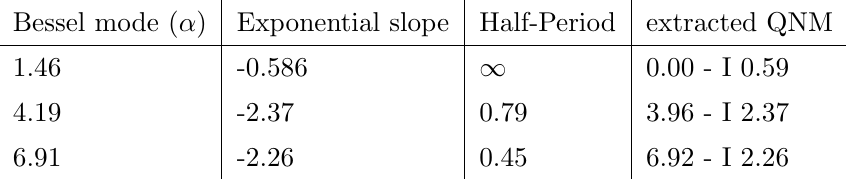
Figure 5 . Late time relaxation analysis after the fast quench. Left panel: time evolution of the Bessel spectrum. The modes with (cid:11) > 2 decay faster and oscillate, while the modes with (cid:11) < 2 decay slower in pure exponential fashion. This is in qualitative agreement with the spectrum of QNMs, (cid:12)gure 4. Right panel: decay of the selected Bessel modes, shown by grid lines on the left panel. The exponential slope and periodic oscillations are clearly visible on the logarithmic scale. The (cid:12)ts listed in table 1 agree quantitatively with the spectrum of QNMs, (cid:12)gure 4. Bessel mode ( (cid:11) )